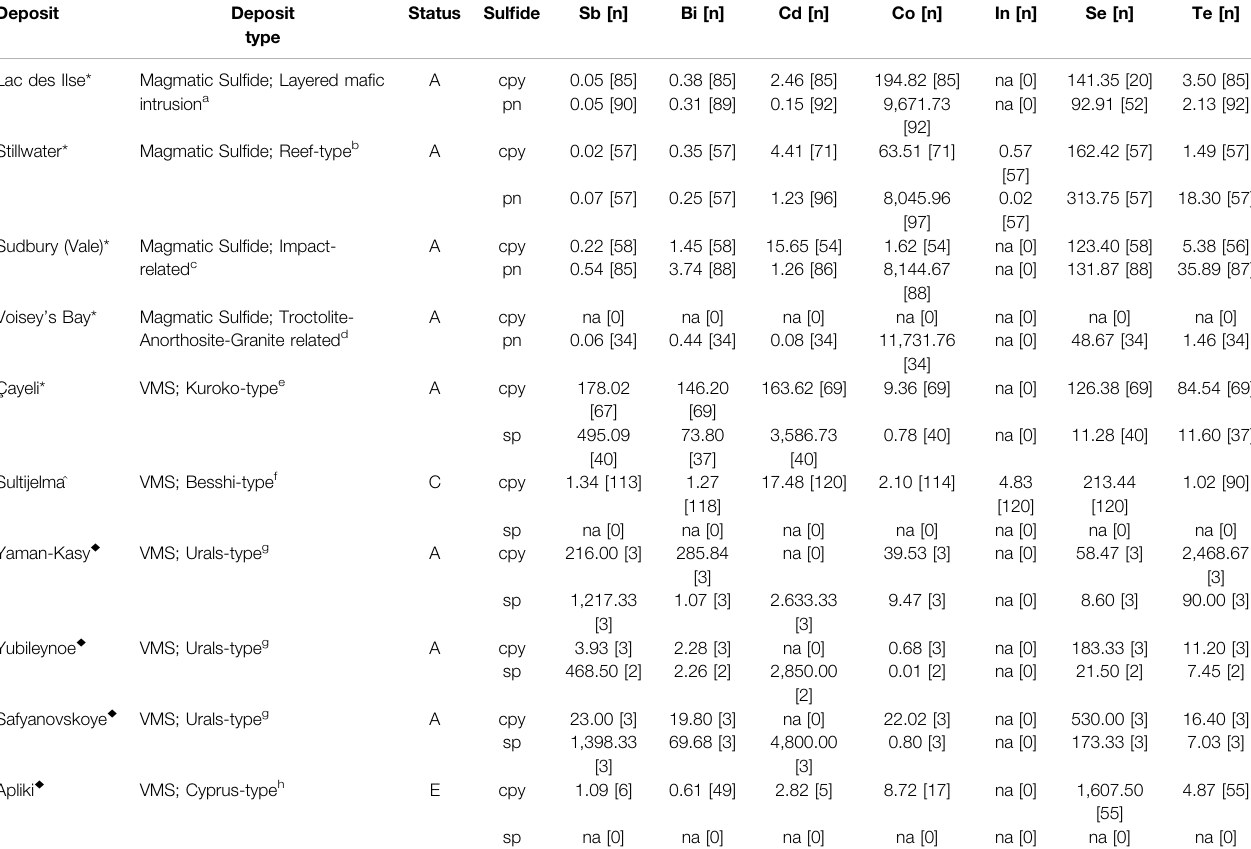
TABLE 3 | Average byproduct critical element concentrations (ppm) in pentlandite, chalcopyrite and sphalerite from select magmatic sul fi de and volcanogenic massive sul fi de deposits.